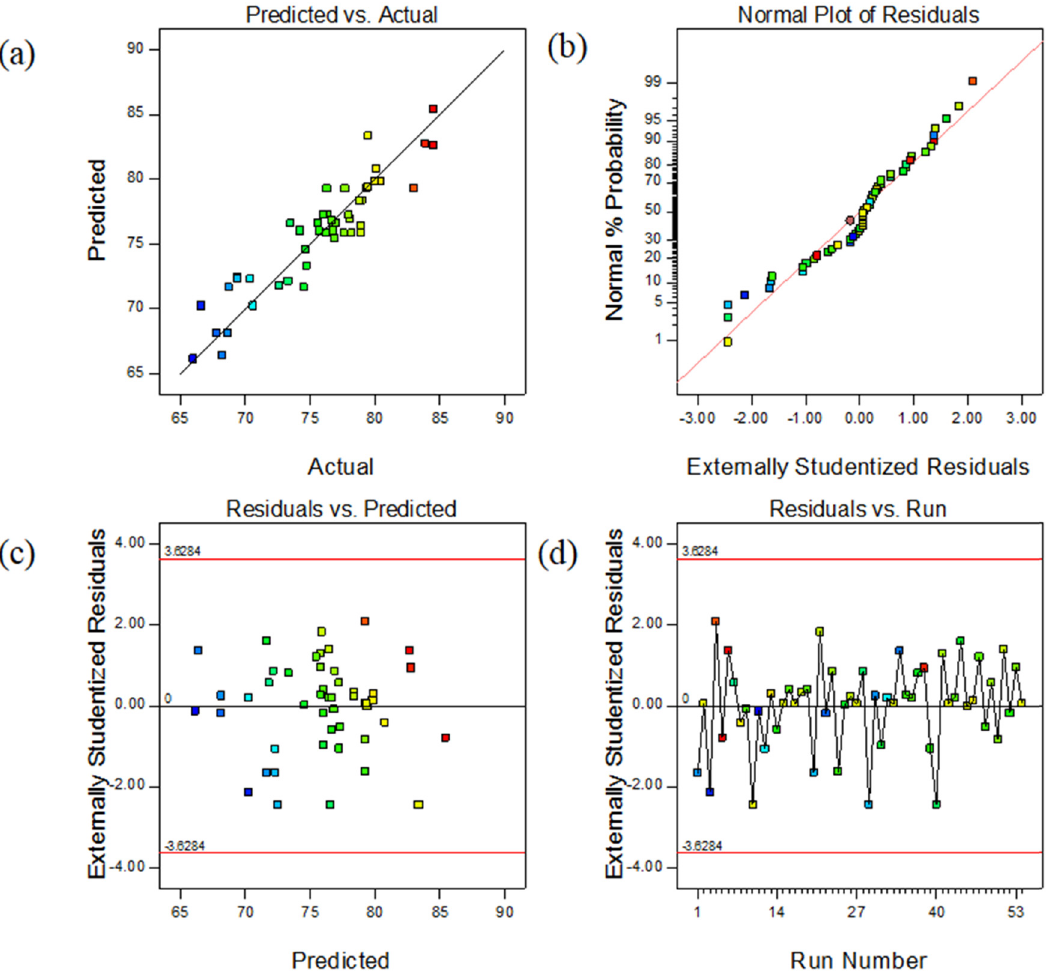
Figure 6: ( a ) Predicted vs experimental contact angle; ( b ) normal% probability and externally studentized residual plot; ( c ) externally studentized residuals vs the predicted contact angle; and ( d ) outlier t